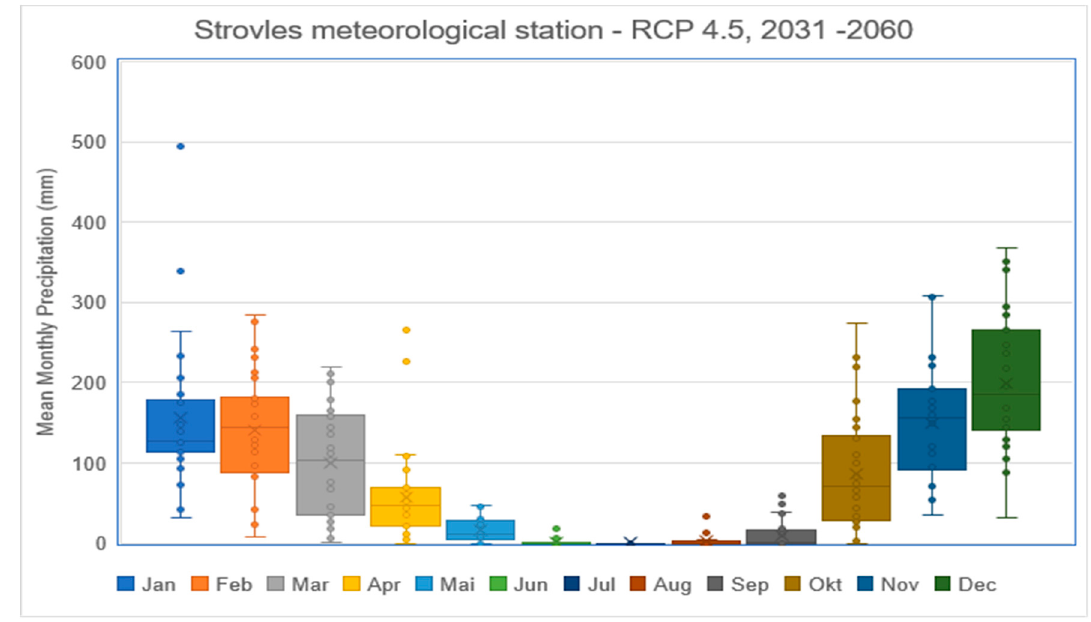
Figure 10. Mean monthly precipitation for 2031–2060 according to RCP4.5 at the Strovles meteorological station.